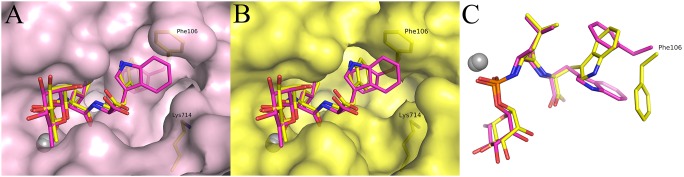
Phosphoramidon binding in wild-type and NEPv.Superposition of NEPv (yellow) and wild-type NEP (1 dmt, magenta) with phosphoramidon bound. The overall binding modes of phosphoramidon are the same, but the C-terminal extension of the molecule binds differently. A) Surface of 1 dmt and B) surface of NEPv. C) Side chain swap of Phe106 and the phosphoramidon tryptophane.